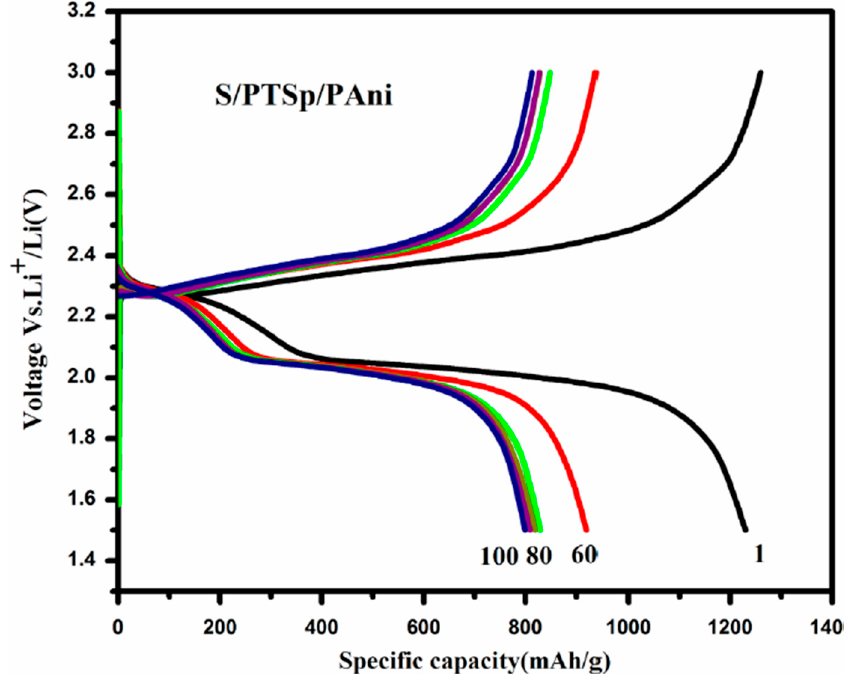
Figure 9. Galvanostatic discharge–charge curves for the S / PTSp / PAni composites at 0.1 C rate.